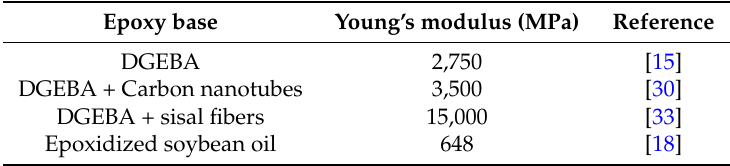
Table 2. Young’s Modulus values of epoxy based thermosets measured in tension mode.